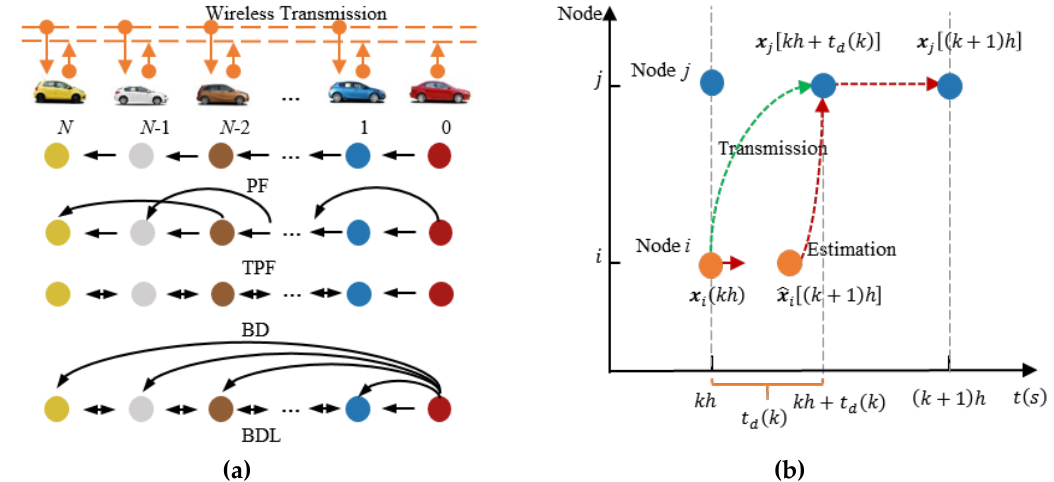
Figure 1. Problems arising from V2V. ( a ) Varieties of information flow topologies. ( b ) Fundamental of state predictor.